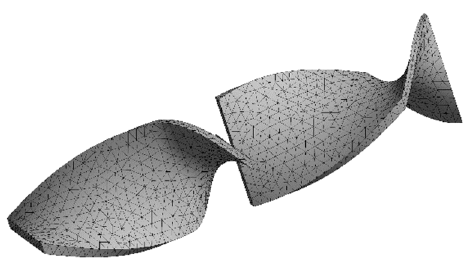
Figure 3. A 3D tetrahedral mesh of a non-standard Kenics static mixer with an eccentricity factor.